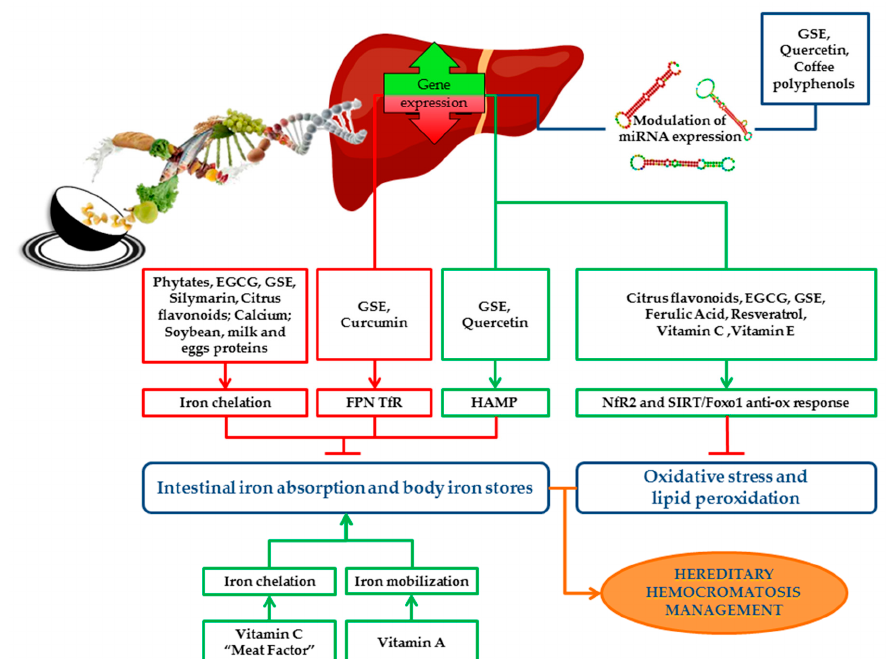
Figure 2. Schematic representation of the impact of bioactive compounds and dietary factors on iron metabolism. Dietary factors and bioactive compounds regulate iron metabolism directly, by enhancing / inhibiting its absorption, storage and recycling, or indirectly by the modulation of miRNAs, which regulate the expression of iron genes. Bioactive compounds act as antioxidants and protect cells and tissues from detrimental e ff ects of iron overload by reducing oxidative stress and lipid peroxidation. The picture shows the main pathways induced (green boxes) or downregulated (red boxes) by bioactive compounds and the final e ff ect on iron absorption, body iron stores, oxidative stress and lipid peroxidation (green arrows indicate positive e ff ects; red “T” arrows indicate inhibitory ones). Nutritional interventions aimed at reducing iron absorption and improving iron-induced oxidative stress may be useful and safe strategies supporting phlebotomy in the management and treatment of HH patients. EGCG: Epigallocatechin-3-gallate; GSE: Grape seed extract; FPN: Ferroportin; TfR: Transferrin receptor; HAMP: Hepcidin antimicrobial peptide gene; ROS: Reactive oxygen species; Nrf2: Nuclear factor erythroid 2 related factor 2; SIRT1: Sirtuin 1; FOXO1: Forkhead box